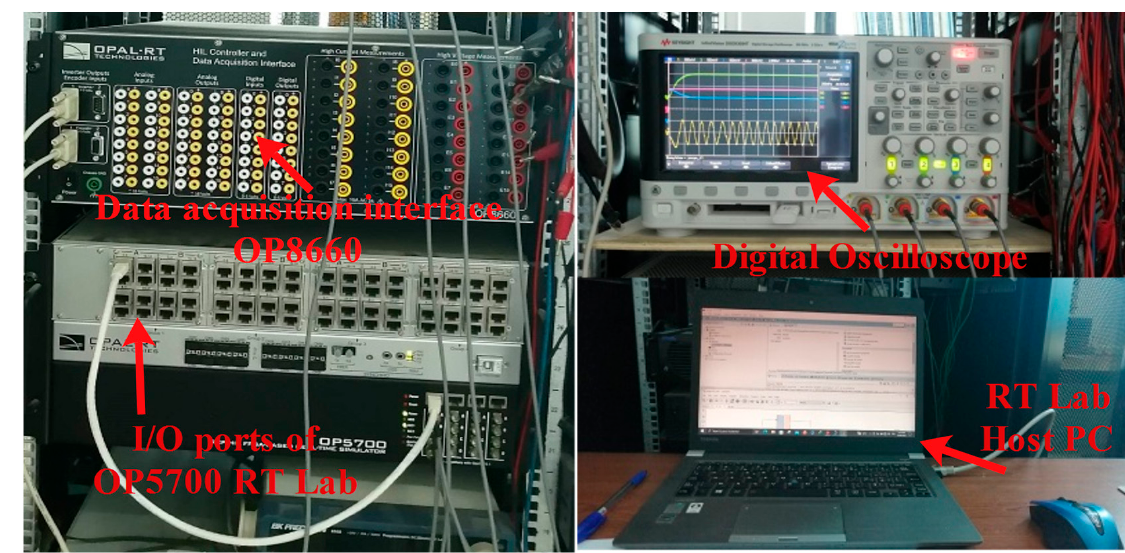
Figure 24. RT Lab real-time simulator work bench.